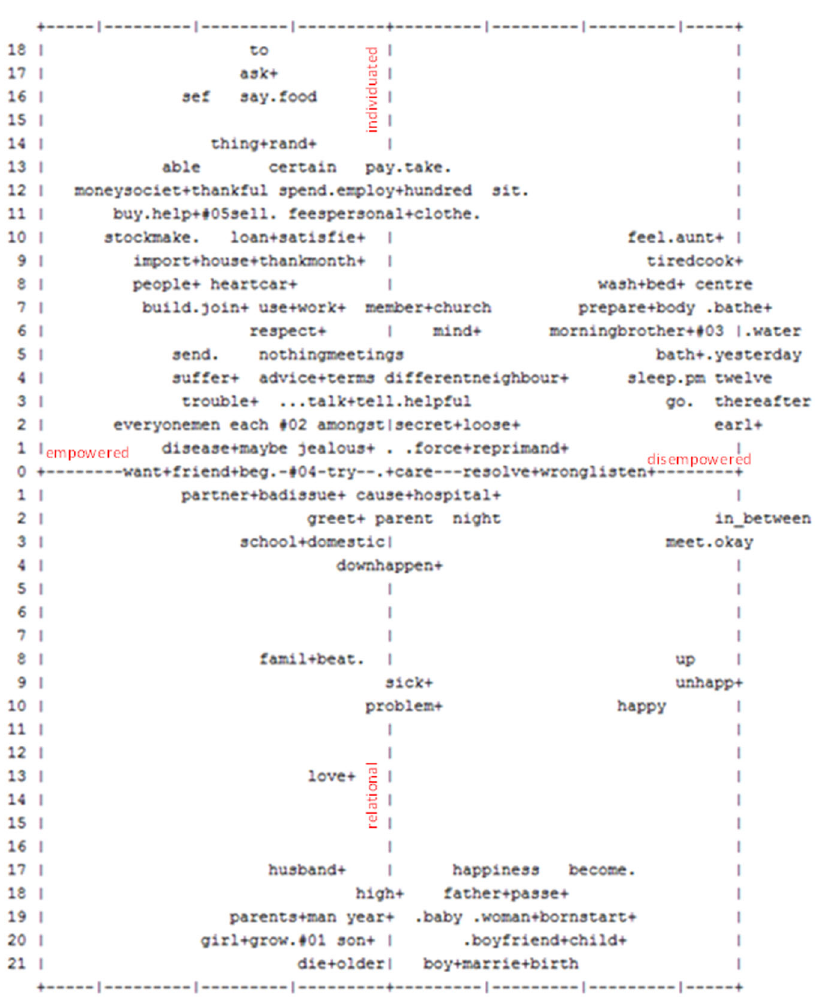
Fig. 6 Vectorial Plane: the two axes represent the fi rst (self-construal) and second (empowerment) latent factors that summarise the content of the focus group discussions. This illustration shows the relationships between the themes, arranged from the most individuated mulier oeconomica at the top of the y -axis to the most relational female socialisation theme at the bottom of the y -axis; and from the most empowered mulier oeconomica on the left-hand side of the x -axis to the most disempowered parenting theme on the right-hand side of the y